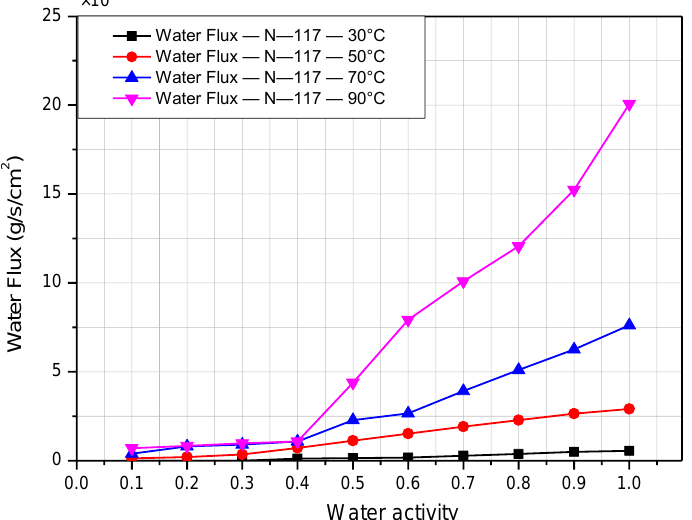
Figure 8. Nafion 117 membrane water flux according to relative humidity at operating temperatures from 30 °C to 90 °C.